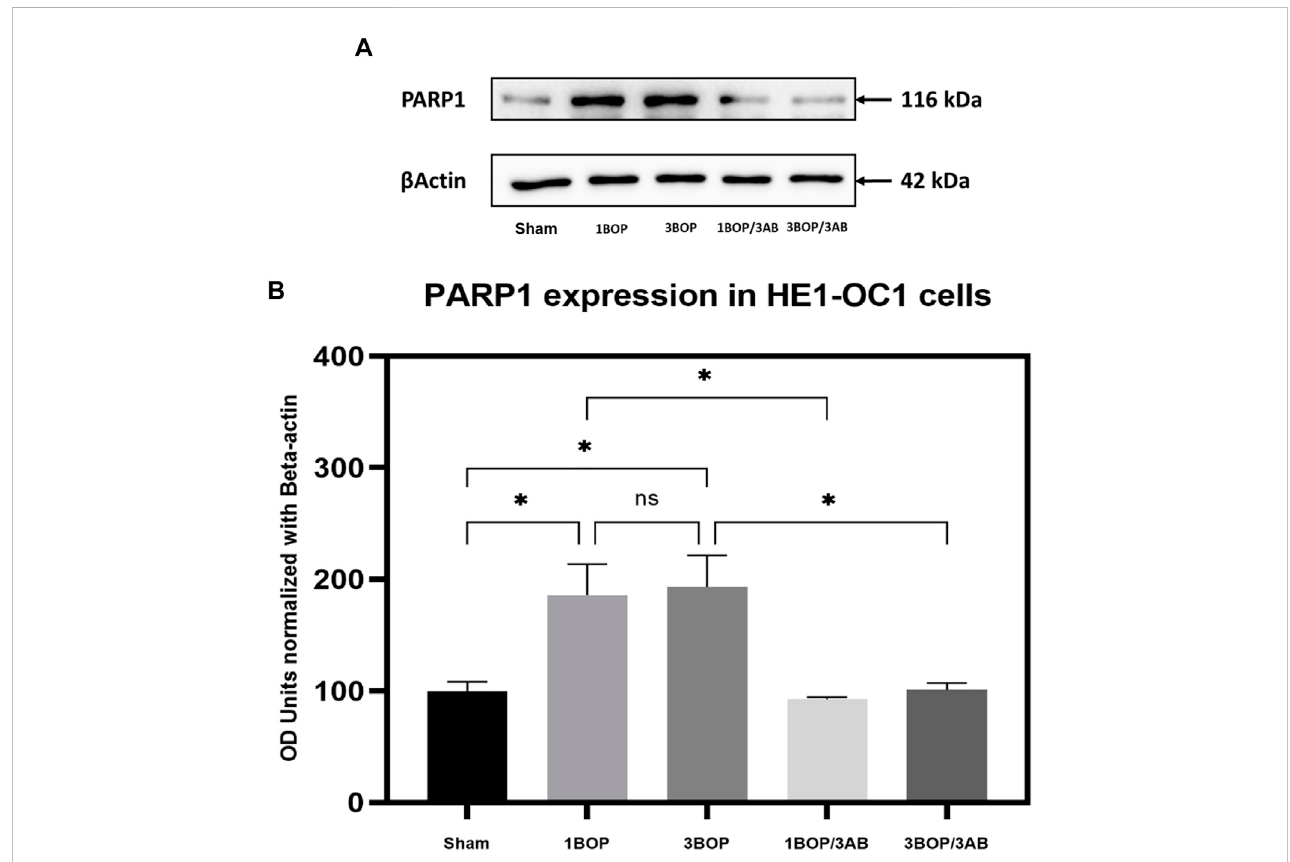
FIGURE 6 Assessment of PARP1 protein expressions by immunoblotting analysis in HEI-OC1 after BOP exposure. The (A) immunoblots shows the protein expressions of PARP1 levels in HEI-OC1 cells. (B) The histogram shows the semi-quantitative protein expression of PARP1 levels in HEI-OC1 cells normalized against the internal control β -Actin. Statistical difference between the cell groups were (* p < 0.05) represented as Mean ± SEM ( n = 3).